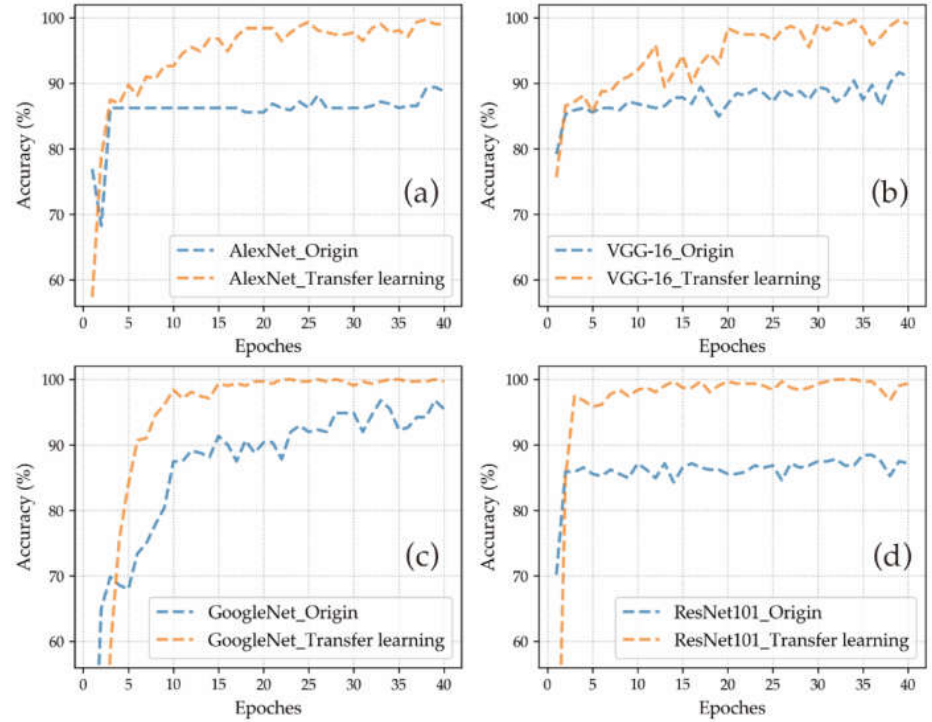
Figure 6. The effect of transfer learning on the prediction accuracy of different CNN models on train dataset. ( a ) AlexNet; ( b ) VGG-16; ( c ) GoogleNet; ( d ) ResNet101. Epoch represents the number of training times using all the samples in the train dataset. Table 2. Impact on model accuracy before and after using transfer learning.